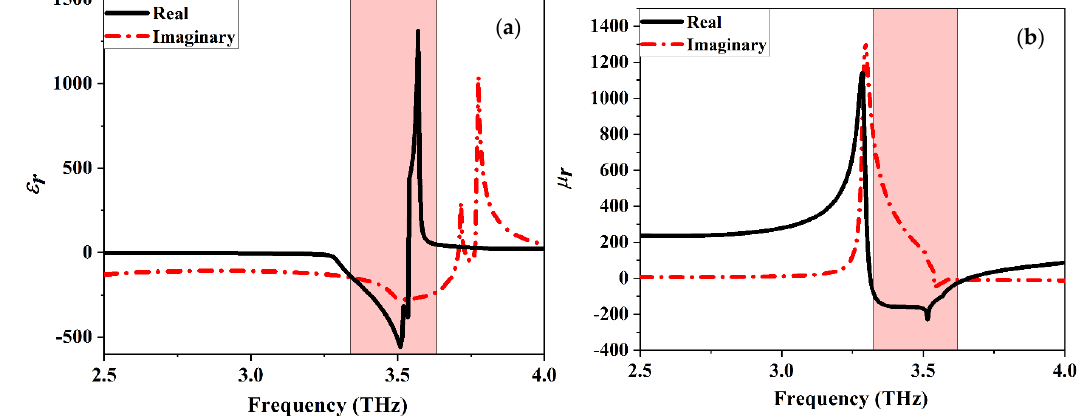
Figure 13. S − Parameters of Dumbbell-structure MTM unit cell.